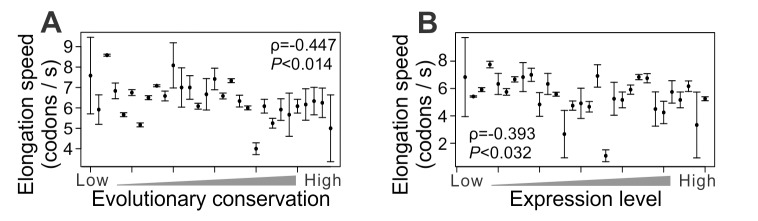
Slower translational elongations of genes with higher demands for translational accuracy, on the basis of ribosome run-off experiment in mouse embryonic stem cells.(A) Average elongation speed for a meta-gene representing a group of genes decreases as the mean evolutionary conservation of the group at the protein sequence level increases. The 1,037 mouse genes analyzed are divided into 30 equal-sized groups, each represented by a meta-gene. Error bar indicates one standard error. (B) Average elongation speed for a meta-gene representing a group of genes decreases as the expression level of the gene group increases. The 381 genes analyzed are divided into 30 equal-sized groups, each represented by a meta-gene. Error bar indicates one standard error.